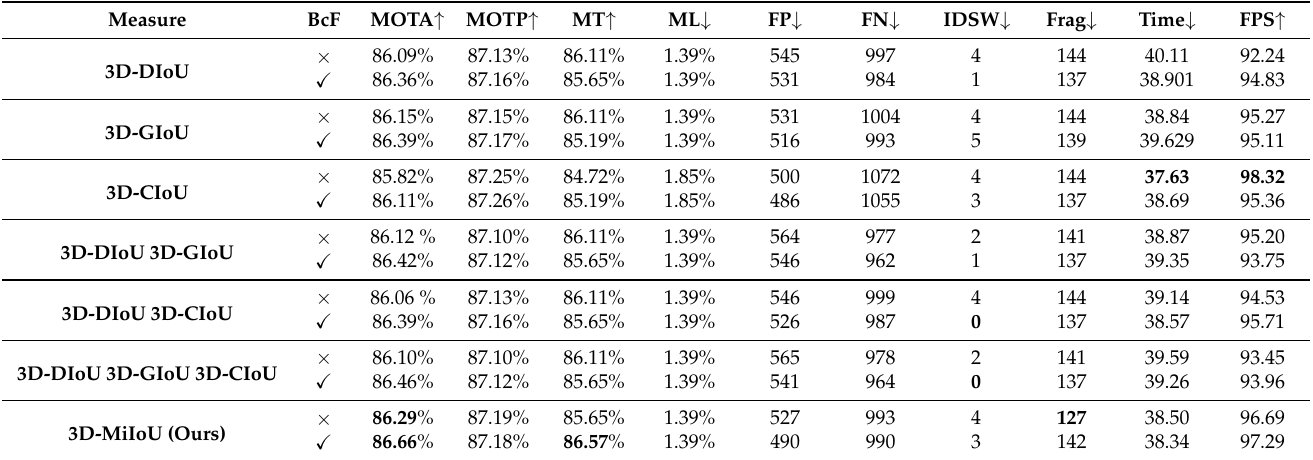
Table 6. Evaluation of different metrics for affinity computation. " × " means without BcF, while " (cid:88) " means with BcF.